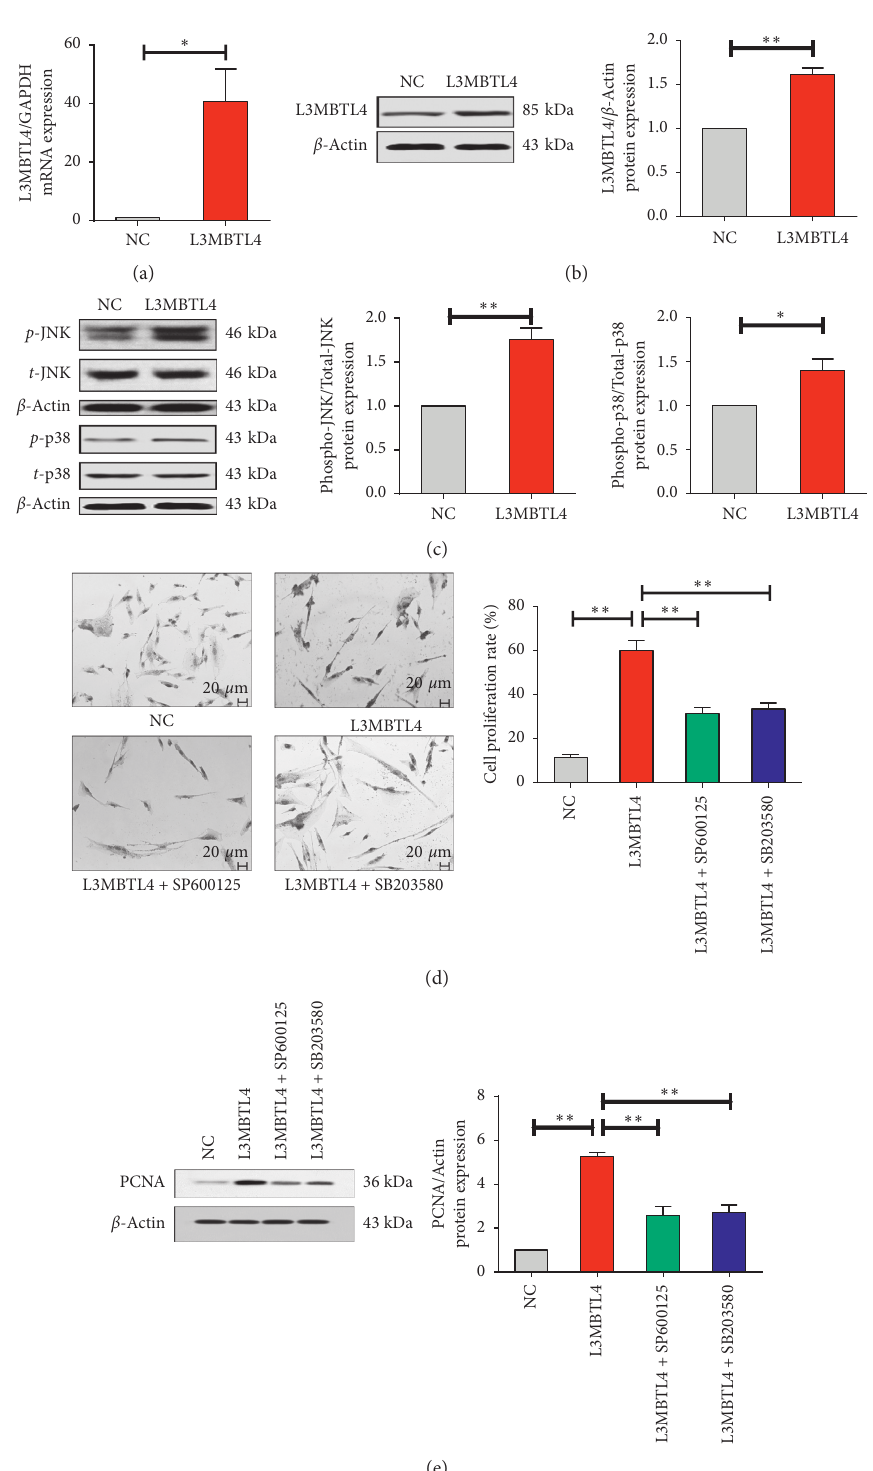
Figure 3: p38/JNK was required for VSMCs proliferation mediated by L3MBTL4 . (a) Relative mRNA expression of L3MBTL4 in negative control (NC) and L3MBTL4 overexpression VSMCs. (b) L3MBTL4 protein levels in NC and L3MBTL4 overexpression VSMCs were measured by Western blot. (c) Western blot analysis validated the phosphorylation levels of p38 and c-Jun N -terminal kinase (JNK) in NC and L3MBTL4 overexpression VSMCs. (d) Proliferation of VSMCs in NC, L3MBTL4 overexpression VSMCs, L3MBTL4 overexpression VSMCs +SP600125, and L3MBTL4 overexpression VSMCs+SB2003580 was measured by BrdU incorporation assay. (e) PCNA expression in each group was determined by Western blot ( n � 3). ∗ p < 0 . 05; ∗∗ p < 0 . 01. All data represent mean ±